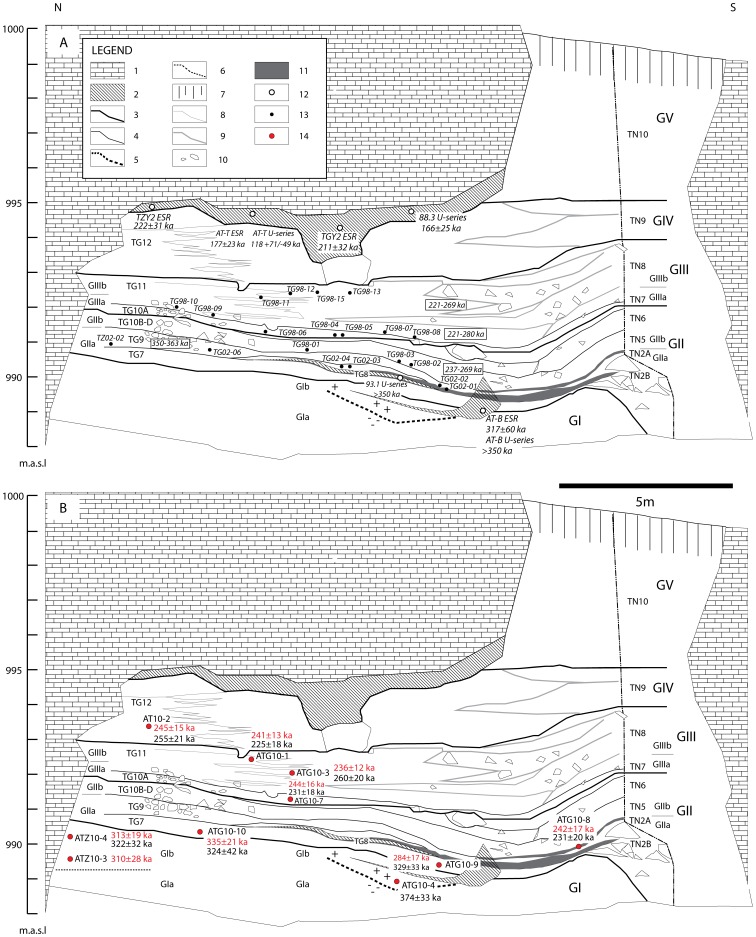
Stratigraphic sequence of the cave deposits at Galería Complex.(a) Ages/sample positions of teeth previously dated by combined ESR/U-series [15] and ages/sample positions of speleothem samples previously dated using U-series and/or ESR [11], [15], [104]. (b) Location of the luminescence dating samples and ages obtained in this study. Legend: (1) Cretaceous limestone; (2) Speleothem; (3) Main stratigraphic uncomformity – allostratigraphic unit (e.g., GII); (4) Lithologic/archaeo-palaeontological level (e.g., TG7); (5) Palaeomagnetic reversal; (6) Zarpazos – tentative GIa/GIb boundary; (7) Soil; (8) Clayey silt/small gravel boundary; (9) Gravels/breccia boundary; (10) Limestone clasts and boulders; (11) Organomineral layer (includes bat guano); (12) U-series and/or ESR speleothem samples; (13) ESR/U-series teeth samples; (14) Luminescence samples (this study).